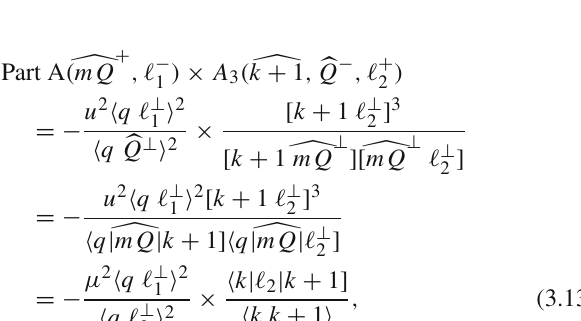
+ , (cid:2) − } (Fig. 2), we 2 1